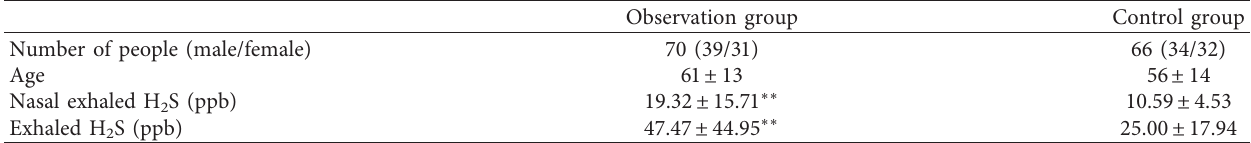
Table 1: Results of exhaled determination in the observation group and control group.